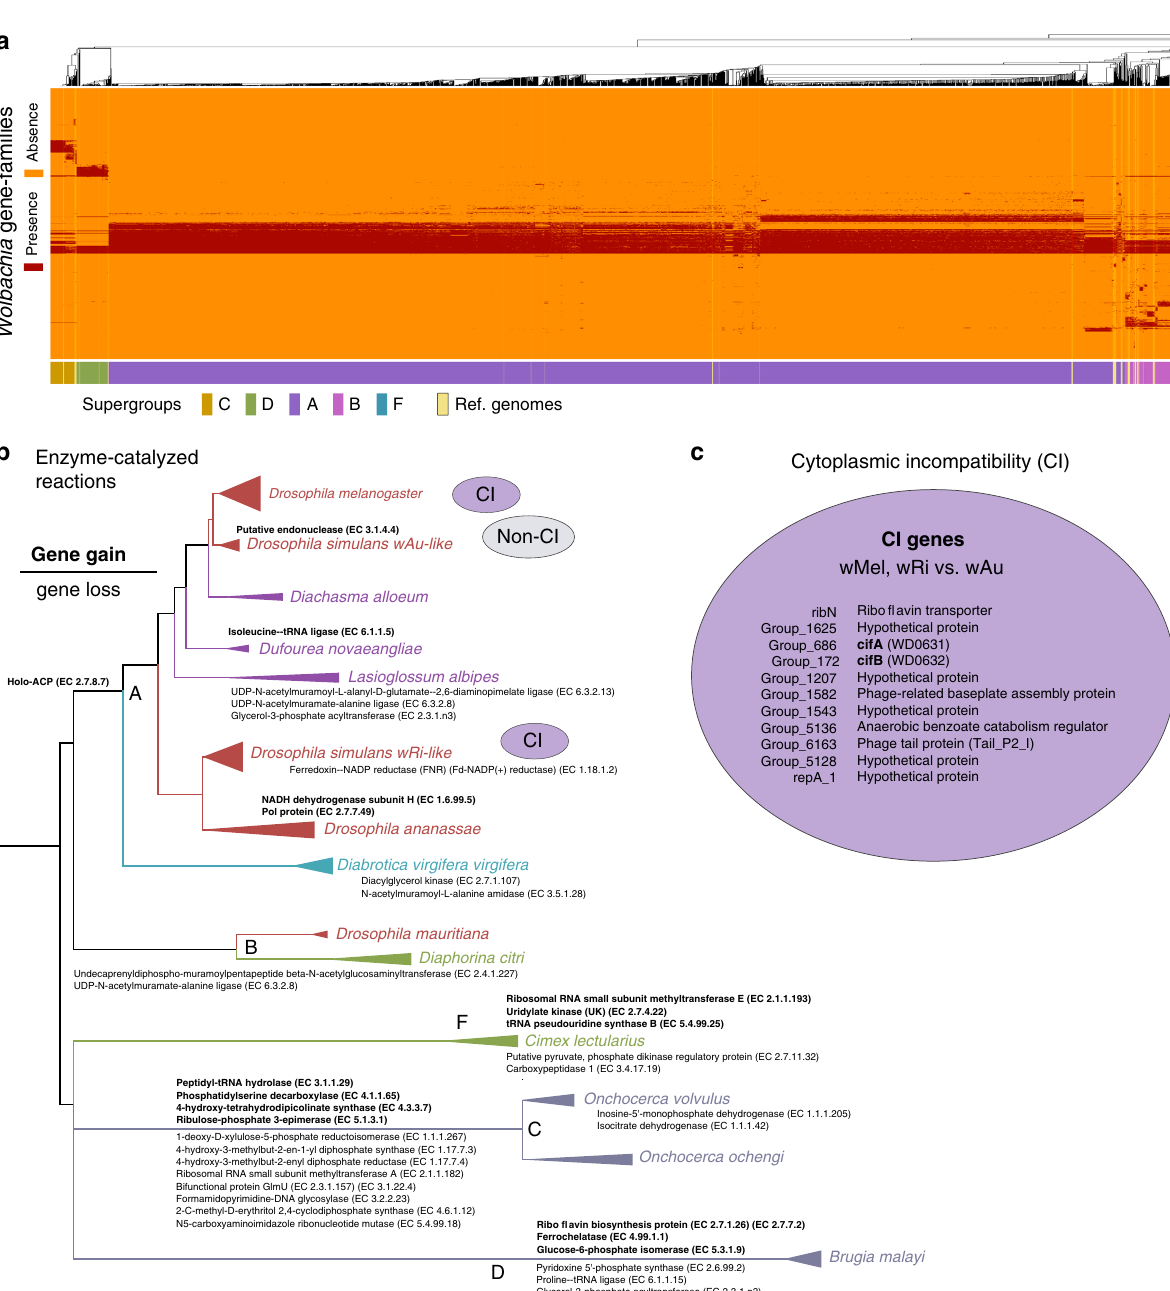
Fig. 3 Functional analyses of Wolbachia pangenomes. a Wolbachia strain discrimination based on presence and absence of genes from the Wolbachia pangenome. Each column represents the identi fi ed gene content of a Wolbachia strain in one of the 1793 positive samples as detected by PanPhlAn. Wolbachia gene pro fi les are hierarchically clustered based on Jaccard distance. b Host speci fi c functional gain and loss. Phylogenetic tree is based on Wolbachia genomes from hosts with at least 4 quality controlled assemblies. Fisher test was applied to identify host lineage-speci fi c functional gain or loss of enzyme categories (EC numbers). c candidate genes signi fi cantly enriched in CI associated